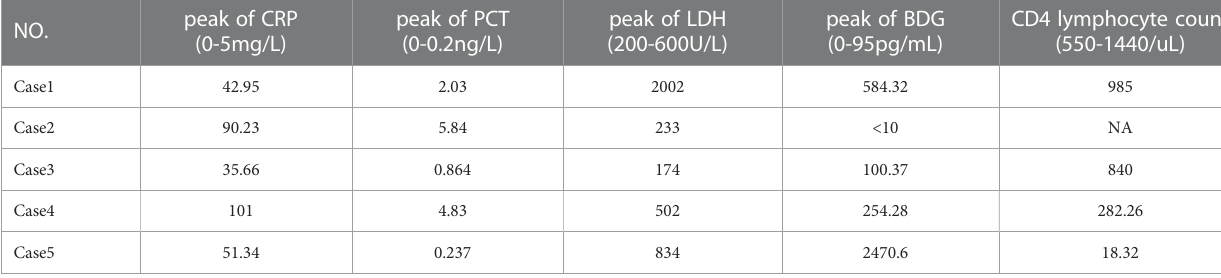
TABLE 1 The results of CRP, PCT, LDH, BDG and CD4 lymphocyte count in fi ve children.